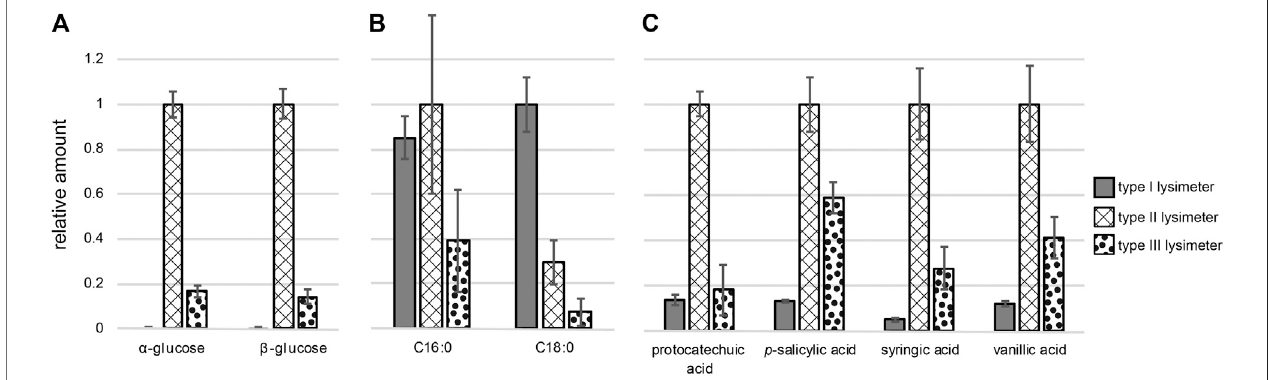
FIGURE5| Relative amounts ofcompounds originatingfromthree differenttypes oflysimeters sortedbycompound class: (A) sugars, (B) fatty acids, (C) phenolic acids (Note: all compounds were detected as (multiple) tri methyl silyl (TMS)-derivative after N , O -bis(trimethylsilyl)tri fl uoroacetamide (BSTFA) treatment). Structure identi fi cation is based on comparison with authentic standards; normalization was carried out using ribitol as internal standard.